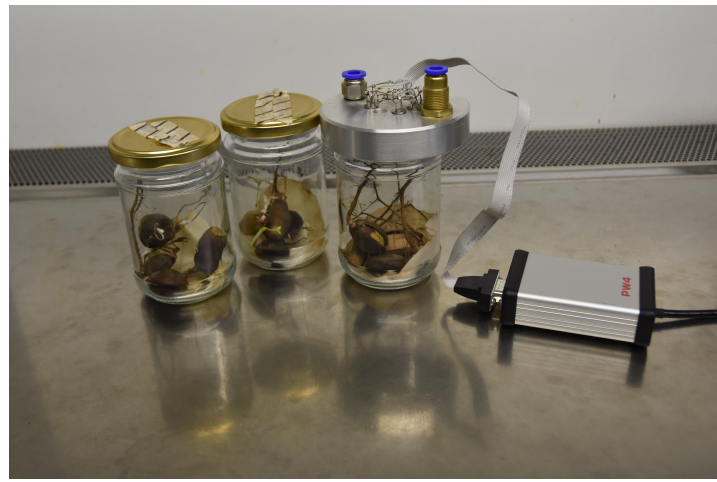
Figure 3. Electronic nose device with measured samples of healthy and infected acorns in